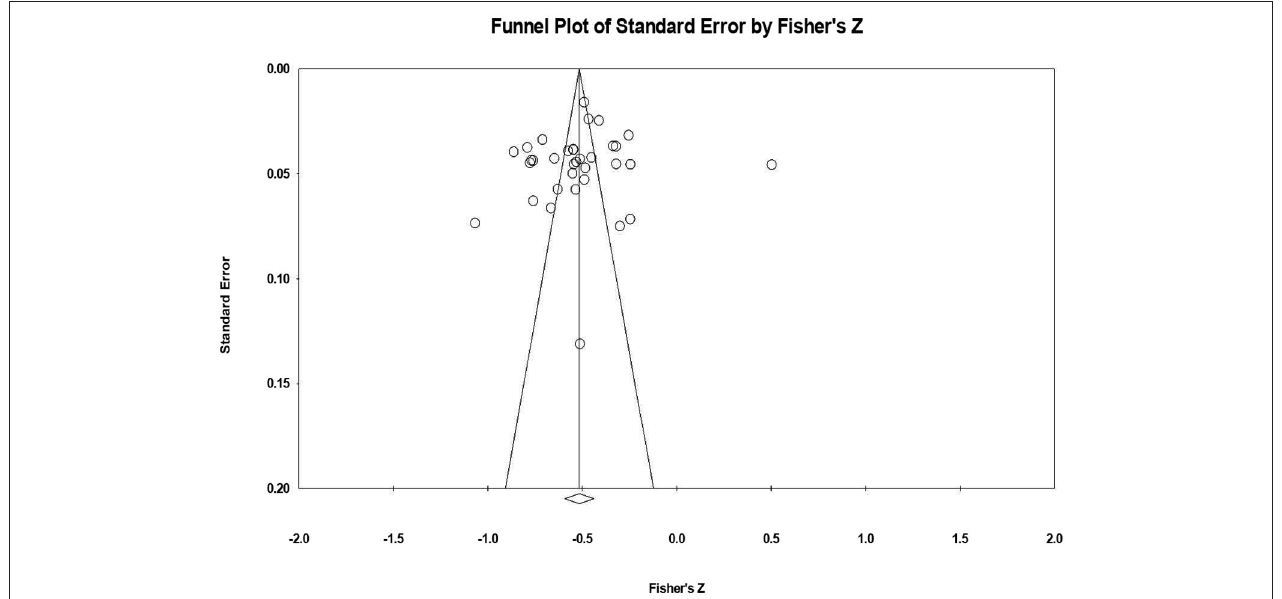
FIGURE 4 | Funnel plot of standard error by Fisher’s Z